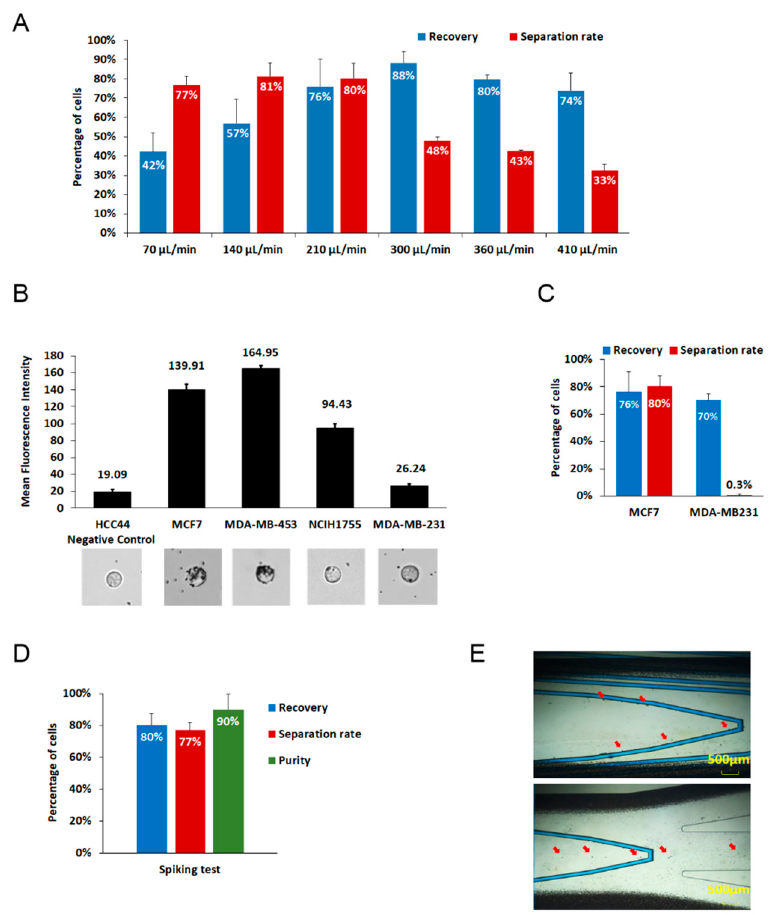
Figure 2. Performance of GenoCTC: ( A ) Microfluidic separation at various flow rates was performed using the EPCAM-positive cells MCF7 (breast cancer cell line), and the best performance was observed at a flow rate of 210 μ L/min. ( B ) Mean fluorescence intensity of EPCAM-FITC for five cancer cell lines as quantified by flow cytometry. HCC44 and MDAMB231 cell lines were used as negative controls (no EpCAM expression). Images of anti-EPCAM-coated magnetic nanobeads binding to the cells are shown below the graph. ( C ) Separation and recovery rates for two different cell lines with varying EPCAM expression. EPCAM-positive MCF7 showed 76% recovery and 80% separation, whereas EPCAM-negative MDAMB231 showed about 70% recovery without any separation. ( D ) A total of 2 × 10 3 magnetic nanobead-bound MCF7 cells were pre-labeled with Hoechst and suspended in a healthy donor’s whole blood. MCF7 cells were isolated at a flow rate of 90 μ L/min and showed about 80% recovery, 72% separation, and 90% purity. ( E ) Images of the spiked sample during cell isolation. The images show the process of isolation of the spiked sample, and the red arrows in the images indicate bead-bound MCF7 cells, which were selectively isolated. Data are presented as the mean ± s.e.m of five experiments.